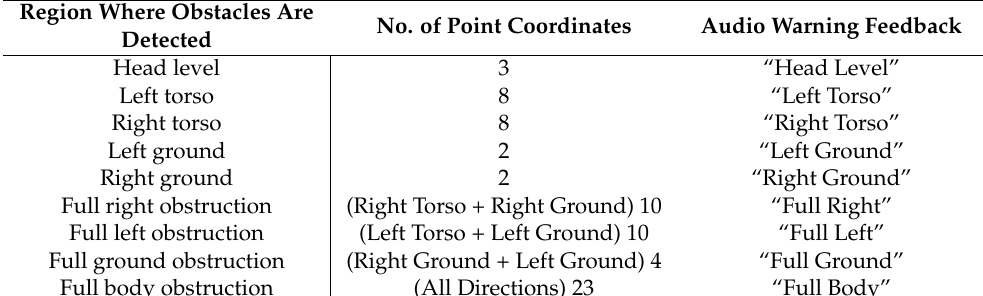
Table 1. List of regions where obstacles are detected, the number of point coordinates per direction and audio warning feedbacks.